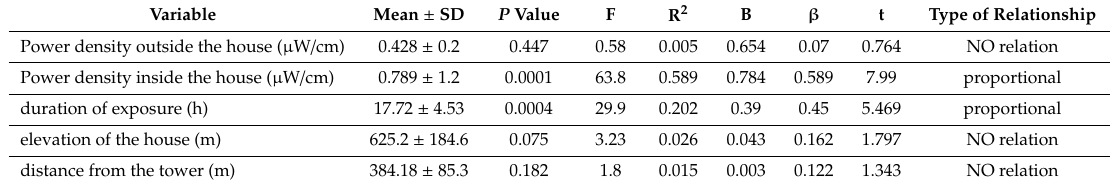
Table 4. Regression analysis for tested continuous variables and GST activity.